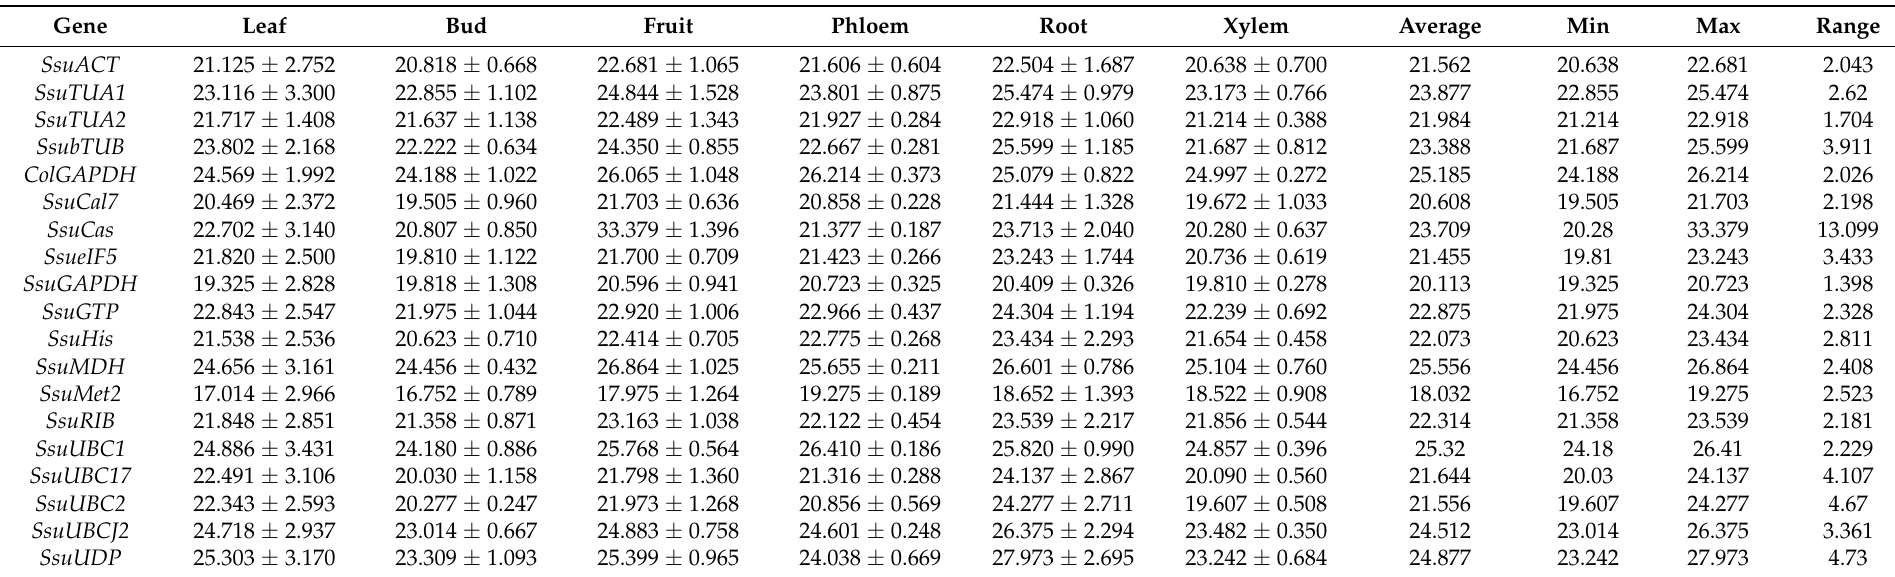
Table 2. Average Ct (cycle threshold) values ± SD (standard deviation) of candidate reference genes in different tissues of Schima superba